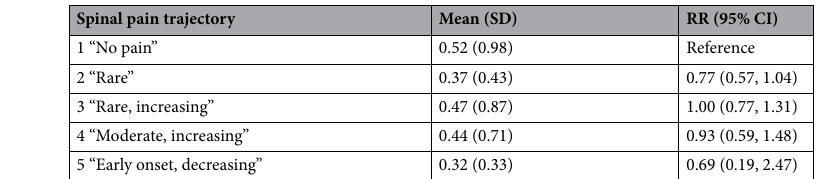
Table 2. Mean hs-CRP estimates at baseline and risk ratios for each of the non-traumatic spinal pain trajectory subgroups compared to the “no pain” subgroup. Models adjusted for pubertal status, body